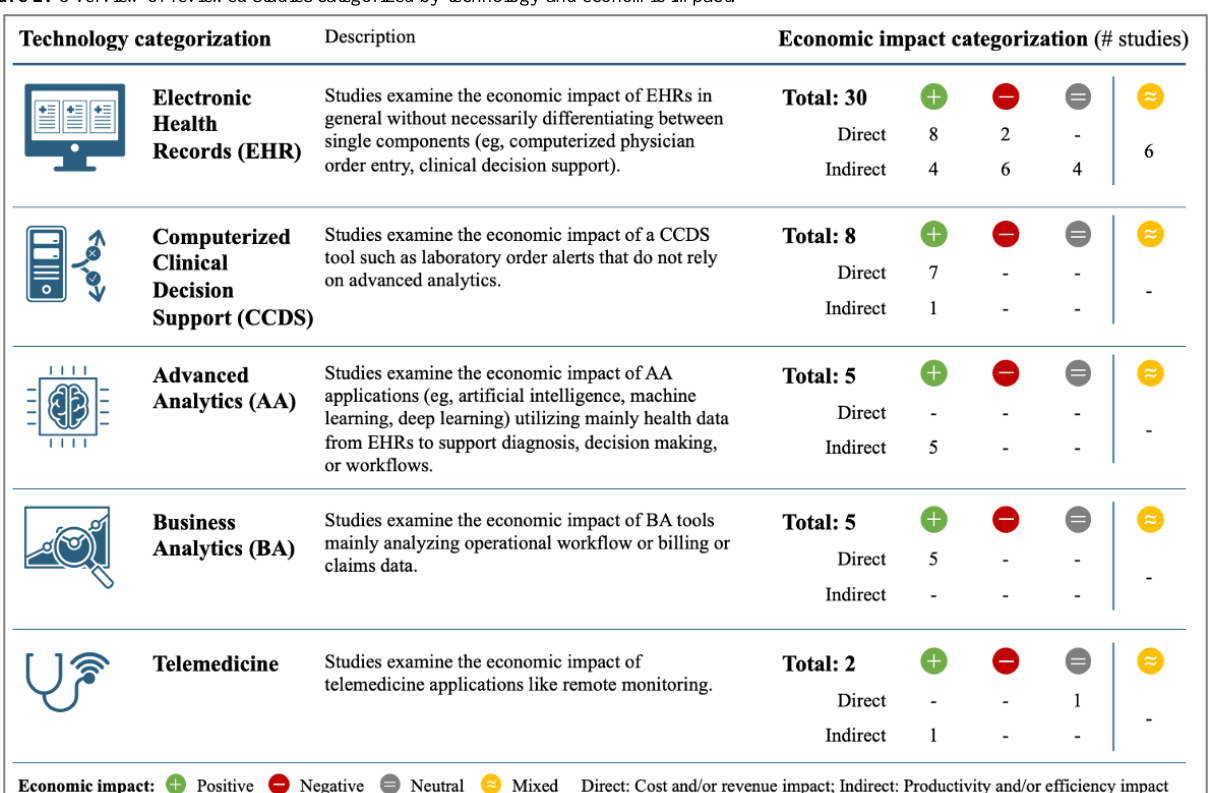
Figure 2. Overview of reviewed studies categorized by technology and economic